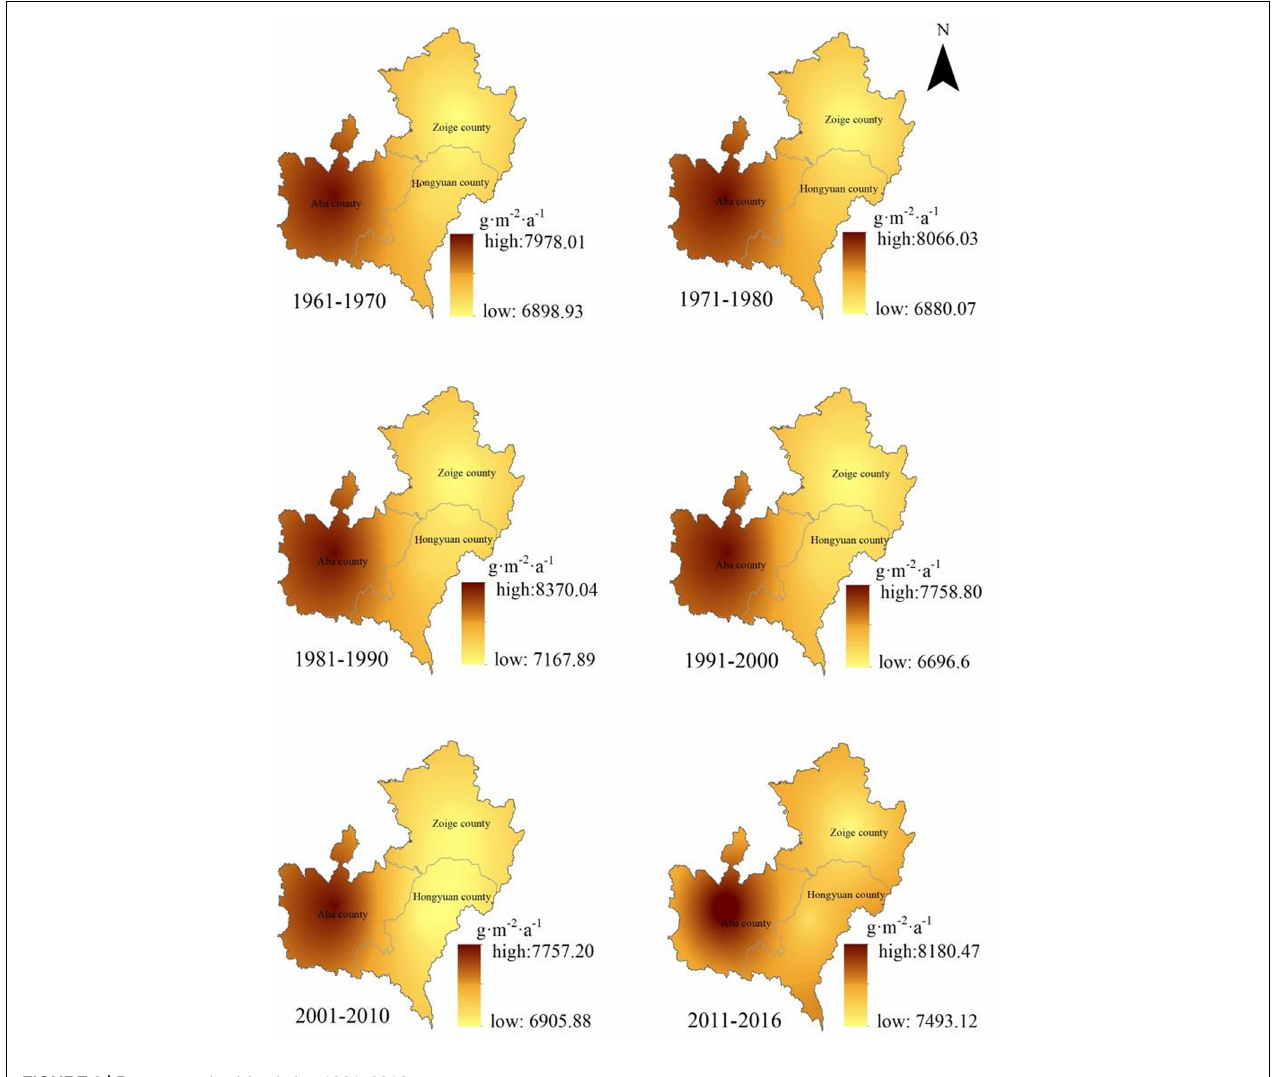
FIGURE 8 | Pasture productivity during 1961–2016.